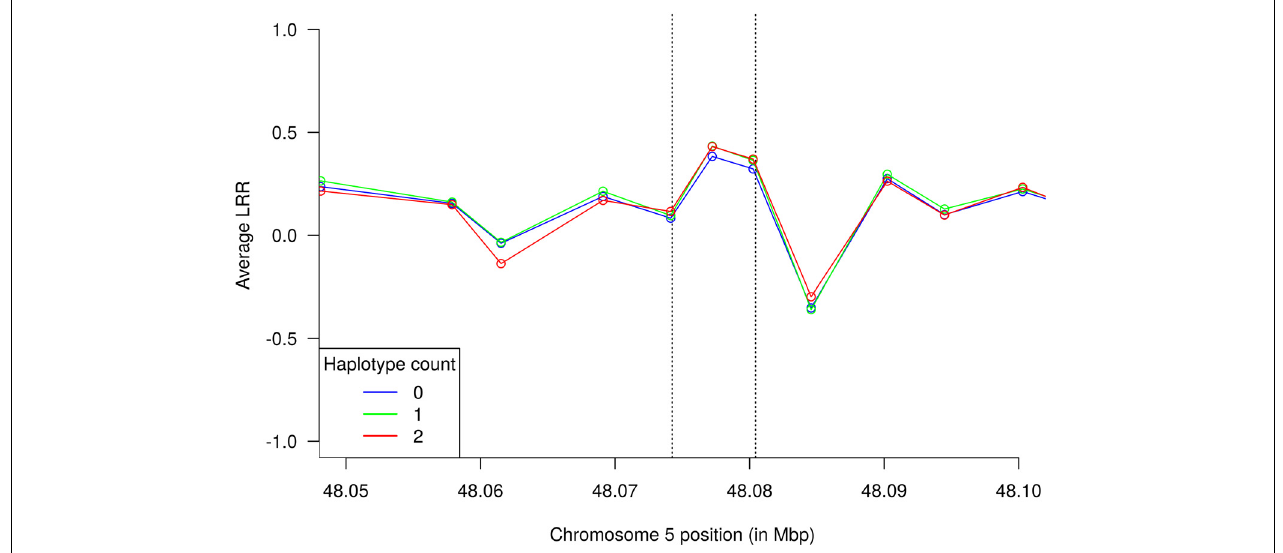
FIGURE 6 | Schematic of the main genes involved in the insulin-like growth pathway. Protein tertiary structures displayed in this figure were built with SWISS-MODEL (Bienert et al., 2017).